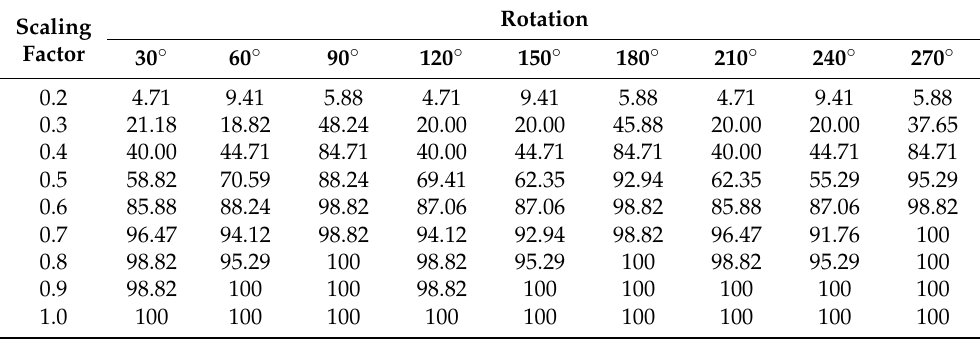
Table 3. The correct recognition rates for a combination of rotation angles and scaling factors for the log-polar DWT-FFT2 method for the printed Chinese character